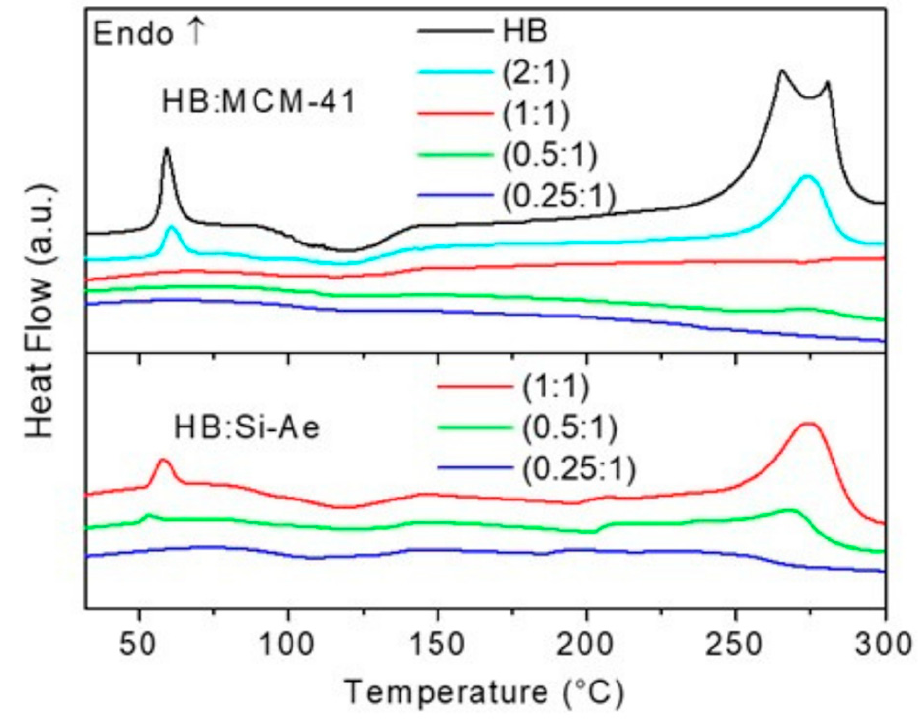
Figure 1. DTA results of HB:MCM-41 and HB:Si-Ae at different loading of HB.